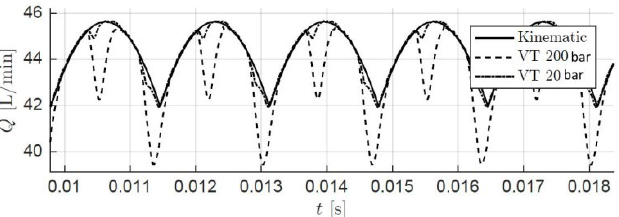
Figure 2. The change of kinematic ripple under 2000 RPM 200-bar condition for the volume-termination circuit (VT) and for the restriction-termination circuit (RT). Data from open-source journal [21].